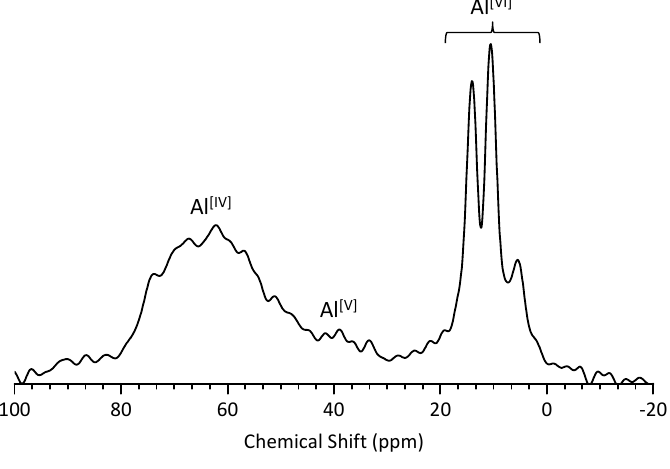
Figure 11. 27 Al MAS NMR spectroscopy of C-FA-28d.